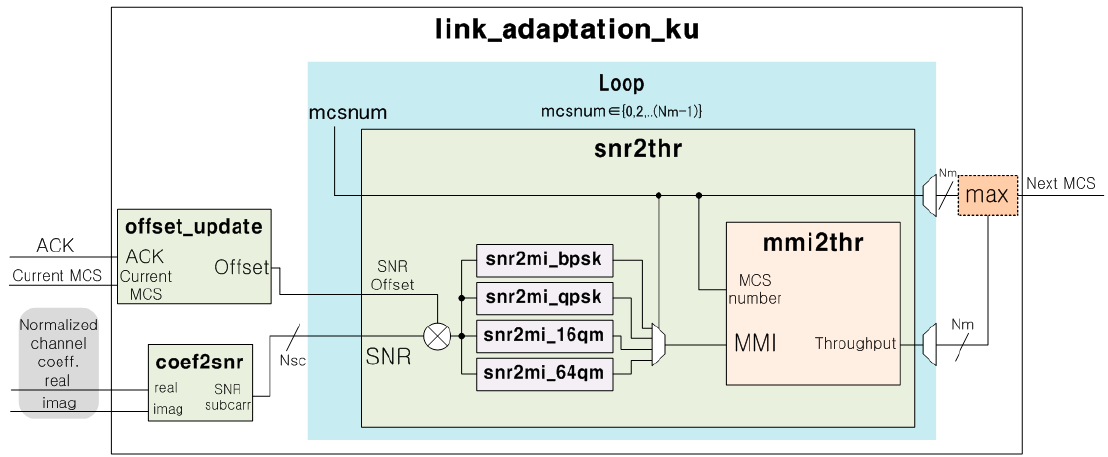
Figure 8. Overall structure of the proposed link adaptation.